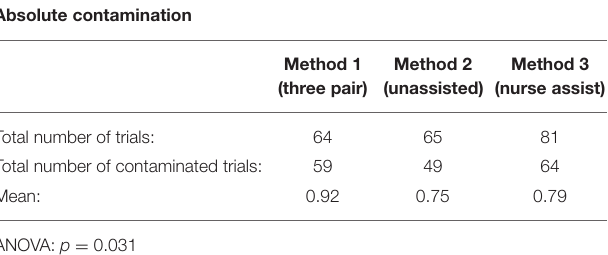
TABLE 3 | Relative contamination pertains to outer surface contamination of Glitterbug TM due to direct contact of a contaminated surface to a clean one (excluding trials with evidence of airborne